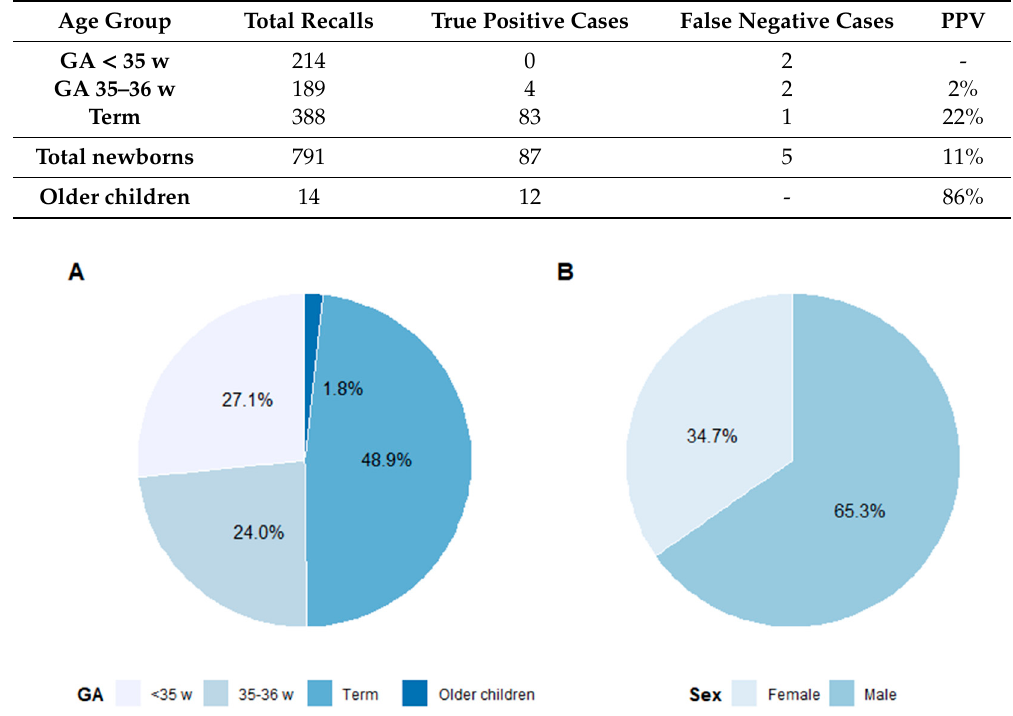
Figure 1. Gestational age ( A ) and sex ( B ) distribution of all recalls in the neonatal screening program for CAH in Sweden during the study